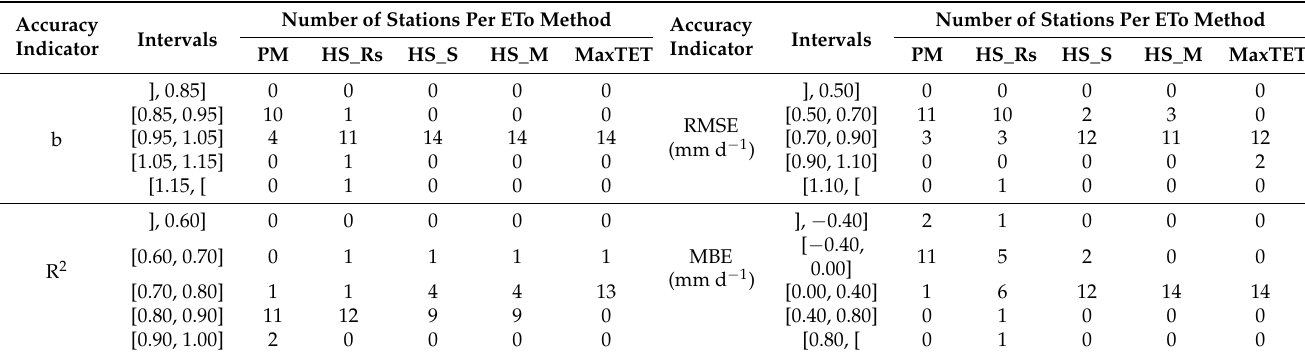
Table 5. Distribution of the statistical accuracy indicators when comparing daily ETo estimated from locally bias corrected NASA POWER data with ETo-PM estimated from observed weather data relative to all locations. Accuracy